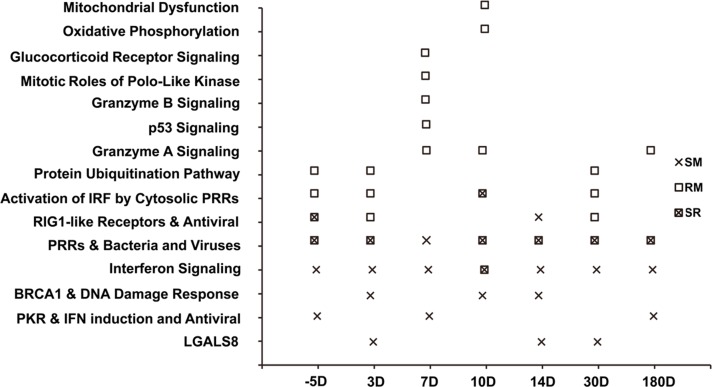
Pathway enrichment analysis of Hub genes in GCNs.“SR” indicates the pathway enriched in both “SM” and “RM”. “PRRs & Bacteria and Viruses” represent the “Role of Pattern Recognition Receptors (PRRs) in Recognition of Bacteria and Viruses”. “PKR & IFN induction and Antiviral” represent the “Role of Protein Kinase R (PKR) in Interferon (IFN) Induction and Antiviral Response” signaling pathway, “BRCA1 & DNA Damage Response” indicate the “Role of the Breast Cancer 1 (BRCA1) gene in DNA Damage Response” signaling pathway.